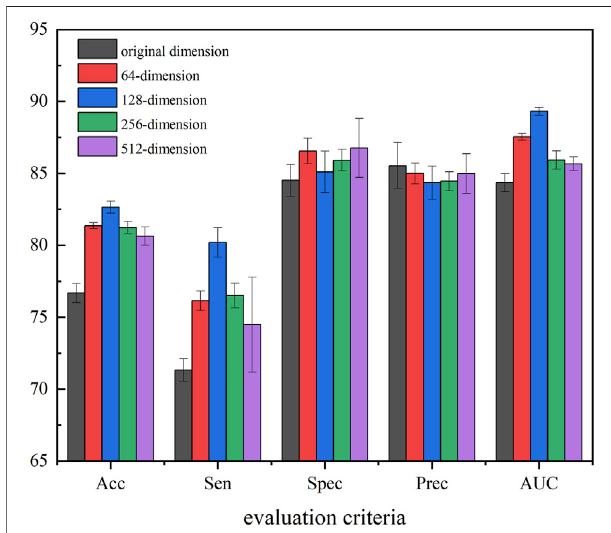
FIGURE 7 | Performance of fi ve-dimensional compression to extract features.